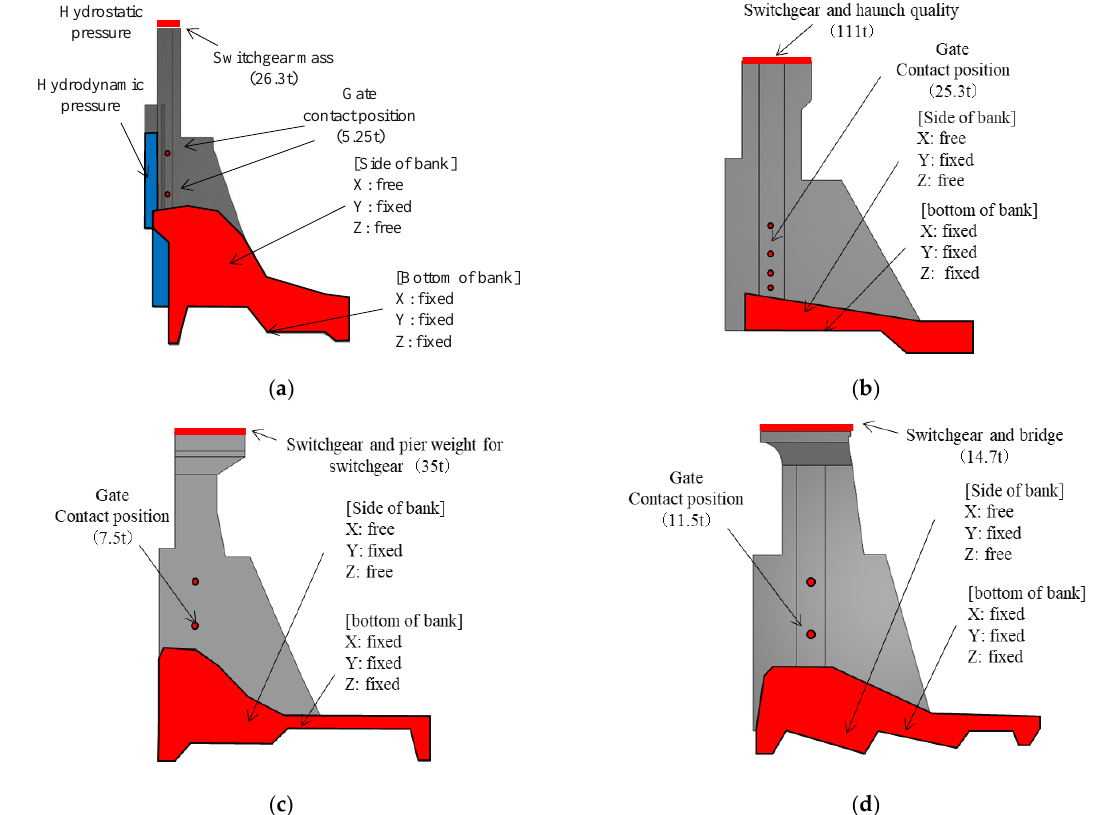
Figure 17. Boundary conditions: ( a ) TYPE-A dam model; ( b ) TYPE-B dam model; ( c ) TYPE-C dam model; ( d ) TYPE-D dam model.